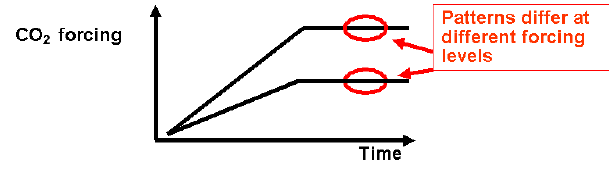
Figure 2. Schematic illustrating the point that non-linear mecha- nisms can cause climate patterns to differ at different forcing (and hence global temperature) levels. This represents two different sce- narios, whose forcing time series is identical apart from a constant scale factor (the higher forcing scenario has about twice the forcing of the lower scenario).